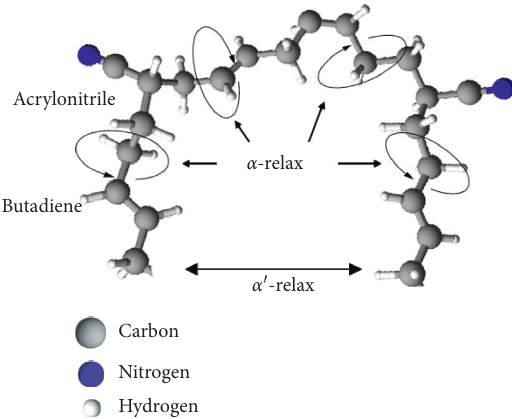
Figure 5: Proposed α and α ′ relaxation processes in the NBR molecular structure.